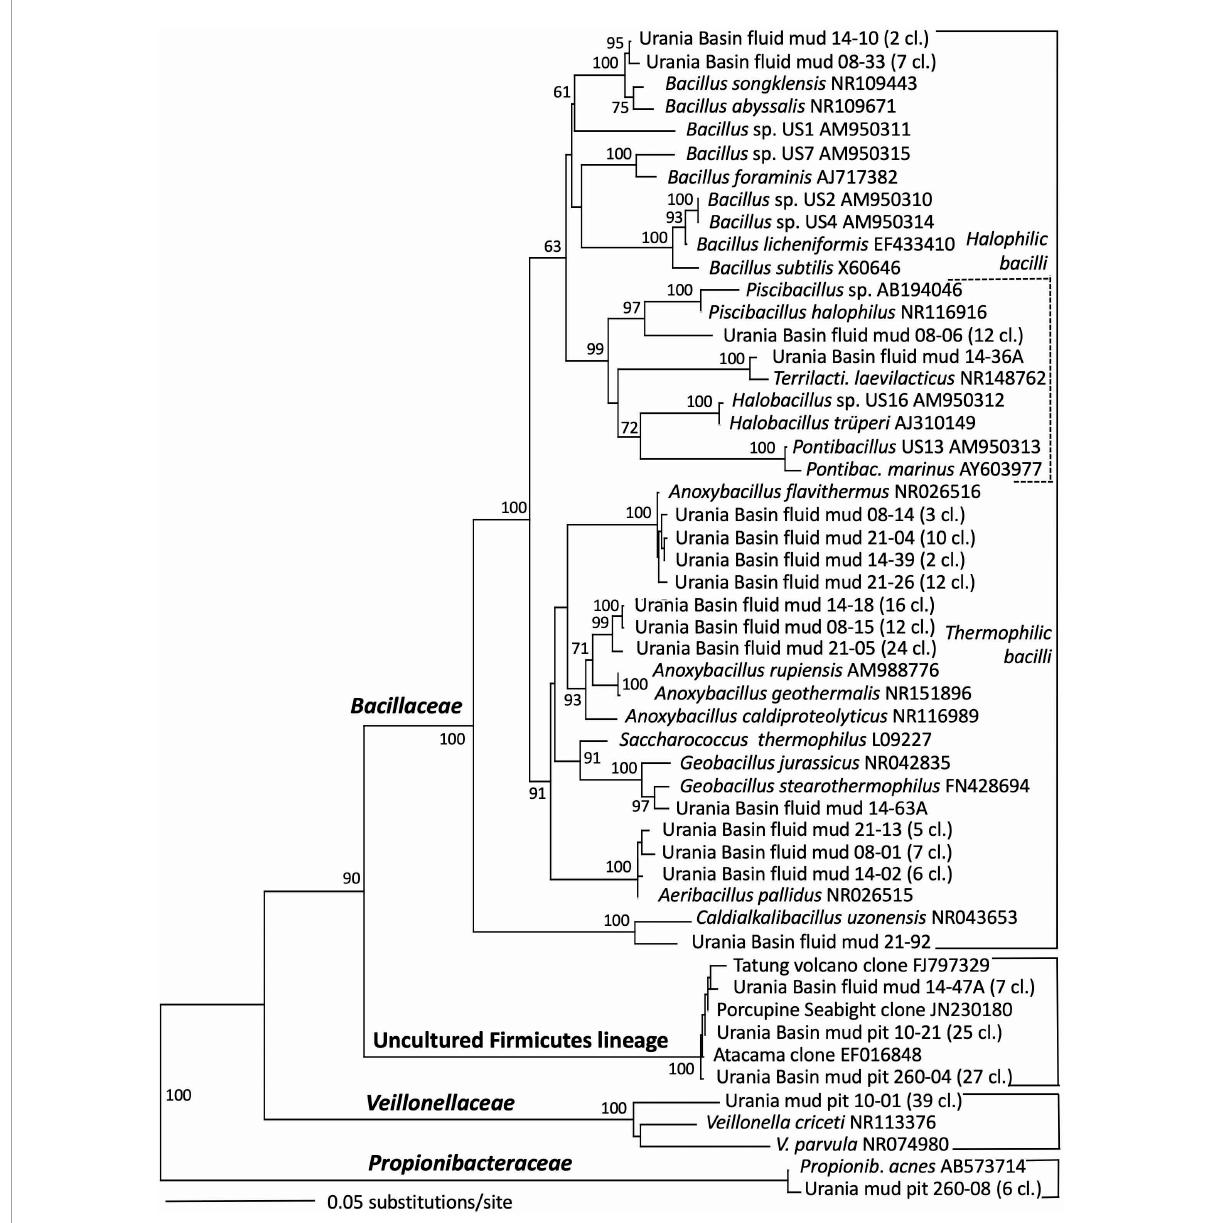
FIGURE6 Phylogeny of the Firmicutes-affiliated 16S rRNA genes based on distance minimum evolution analysis and 1,000 neighbor-joining bootstrap iterations using PAUP (Swofford,